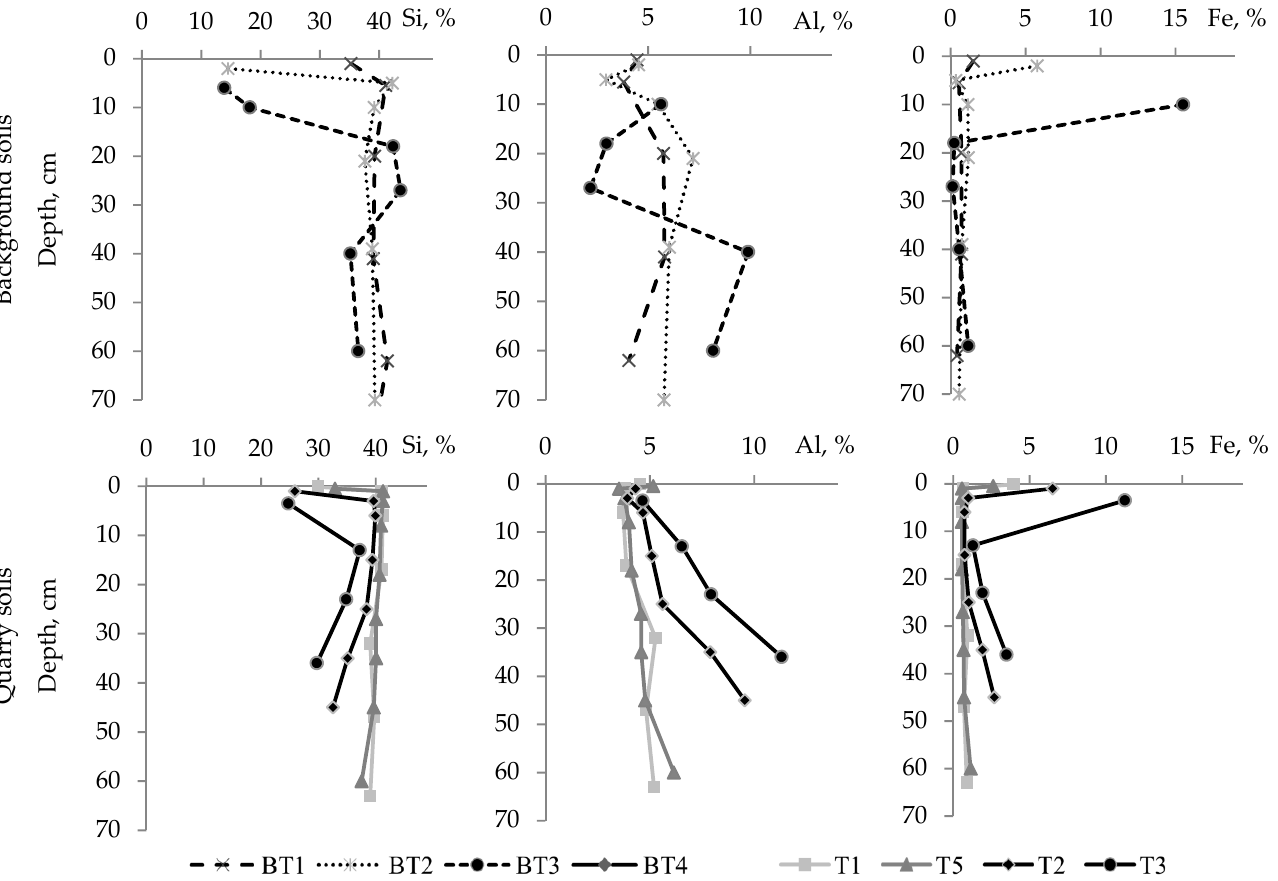
Figure 5. The profile distribution of total content of Si, Al and Fe in the background and quarry soils.